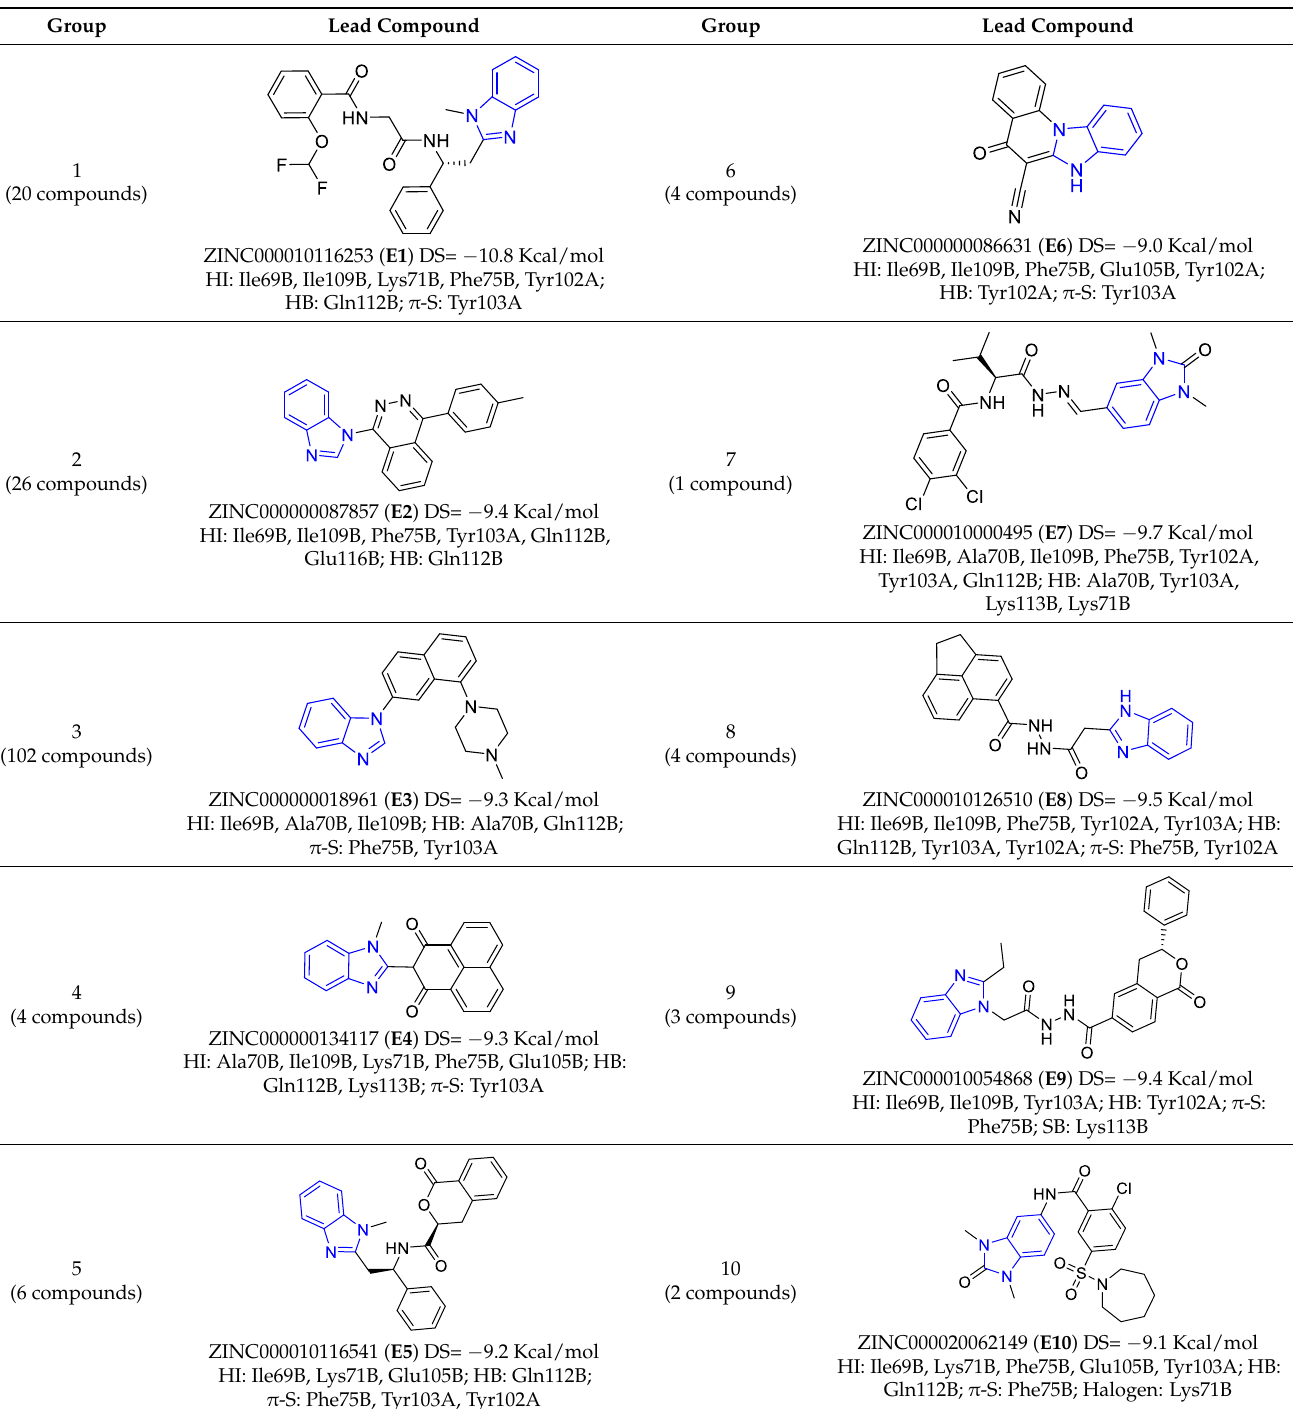
Table 3. Lead compounds from each group obtained by SBVS grouped by structure.